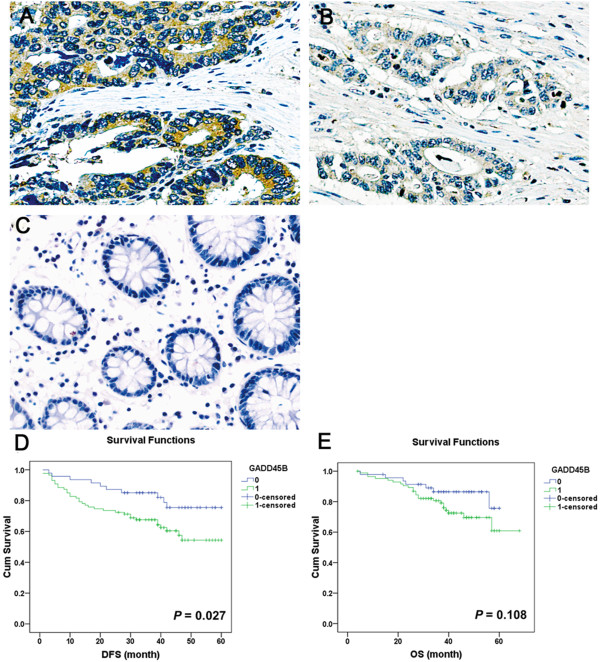
Illustrates IHC of GADD45B in tissue microarrays (EnVision×400). (A) CRC tissues showing strong cytoplasmic staining. (B) CRC tissues showing little or very weak staining of epithelia. (C) ANCT showing negative staining. (D-E) Relationship between GADD45B expression and DFS/OS. 0: GADD45B not overexpressed; 1: GADD45B overexpressed.